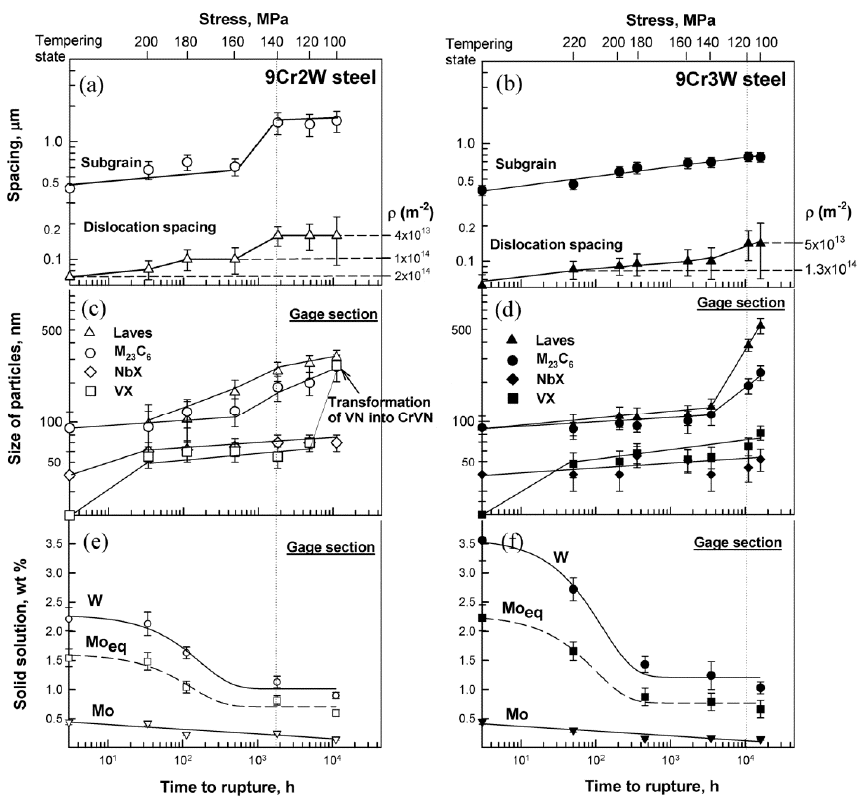
Figure 6. Mean size of spacing ( a , b ), mean size of particles of different phases ( c , d ), and change in W and Mo content in the solid solution ( e , f ) as function of time in the 9Cr2W ( a , c , e ) and 9Cr3W ( b , d , f ) steels during creep tests at 650 °C under the stresses of 100–220 MPa. The vertical dotted lines indicate the time to rupture corresponding to the creep strength breakdown. Mo eq = Mo + 0.5W .